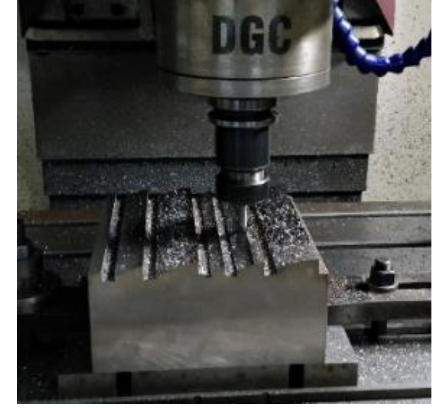
Figure 9. The workpiece geometry.